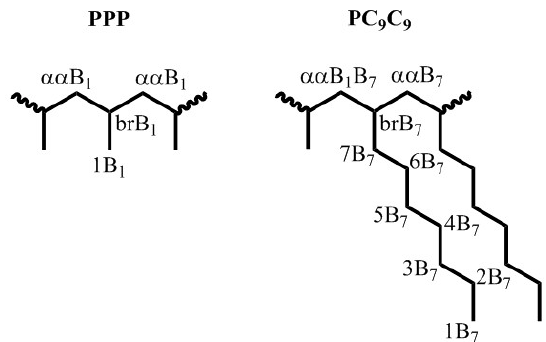
Figure 1. 13 C NMR spectra for the samples obtained at 60 ° C.